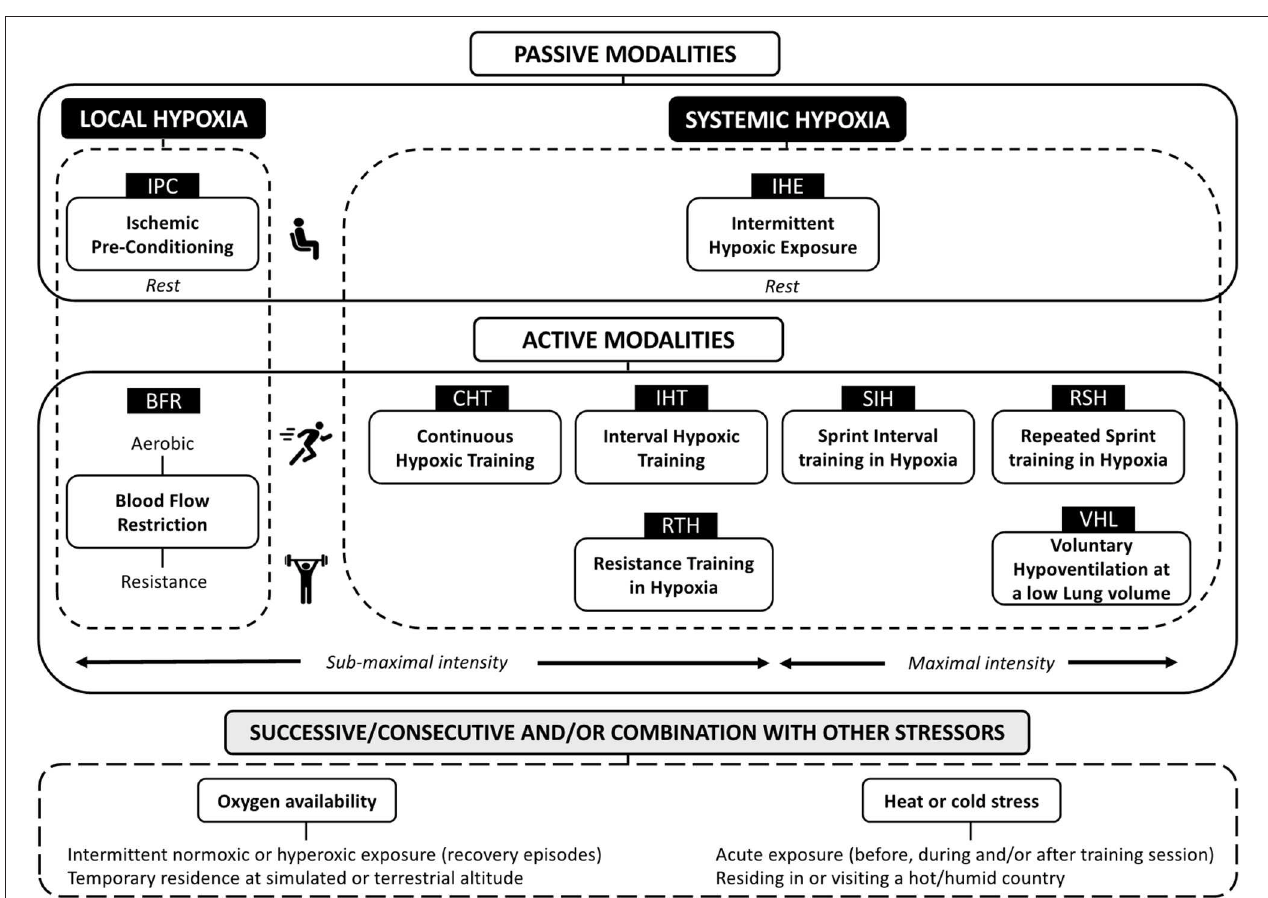
FIGURE 1 | Schematic overview of “living low-training high” (LLTH) altitude/hypoxic